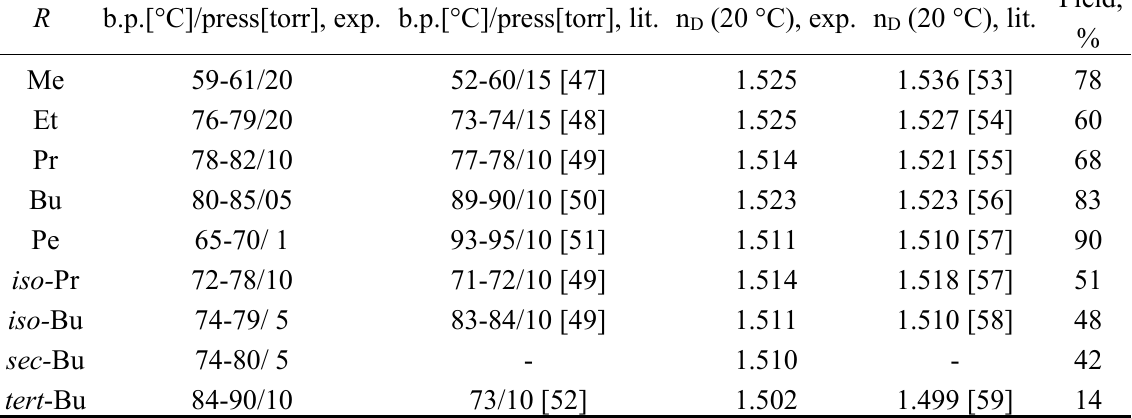
Table V. Physical properties of synthesised α -alkylstyrenes and yields of syntheses with respect to starting